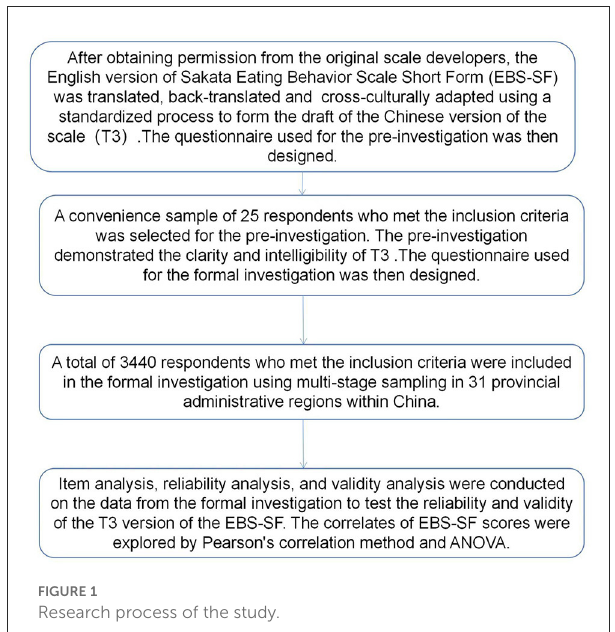
FIGURE1 Research process of the study.